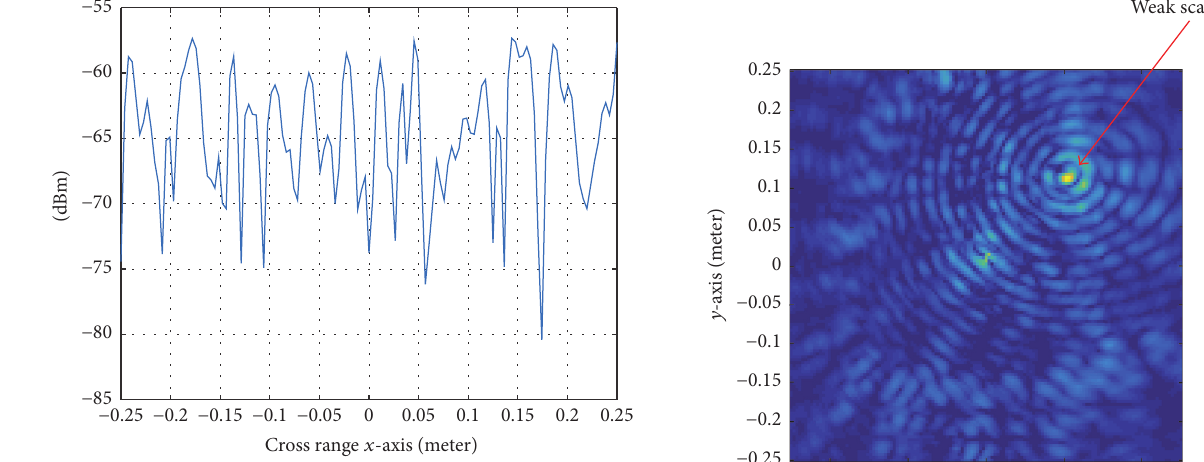
Figure 10: 𝑥 -axis cross range of weak scatterer, showing the sidelobe suppressing weak scatterer signal before applying MRL algorithm.